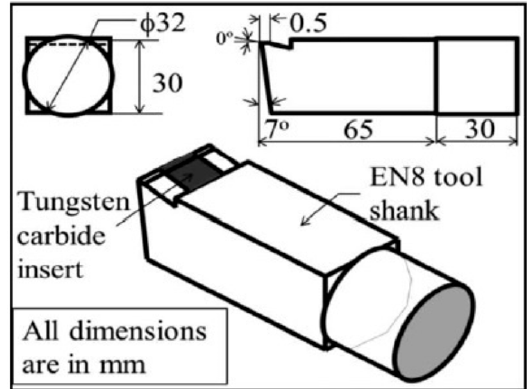
Figure 4. Cutting tool dimensions [22].